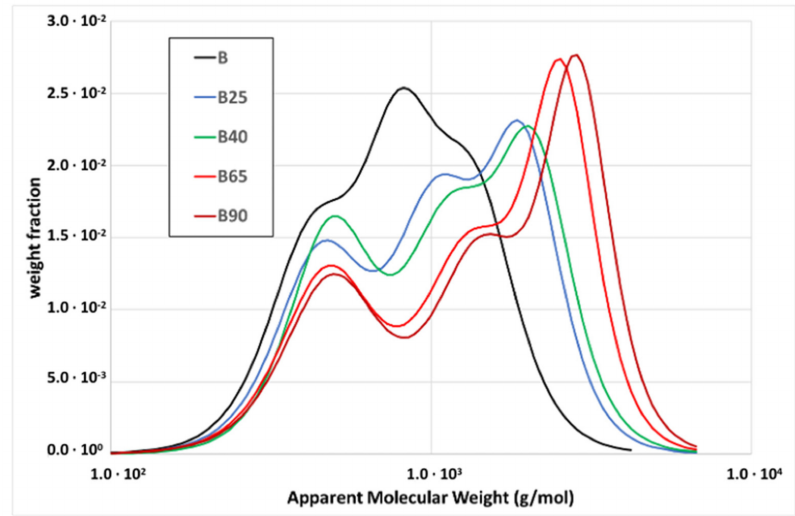
Figure 6. AMWD at different aging times for the base